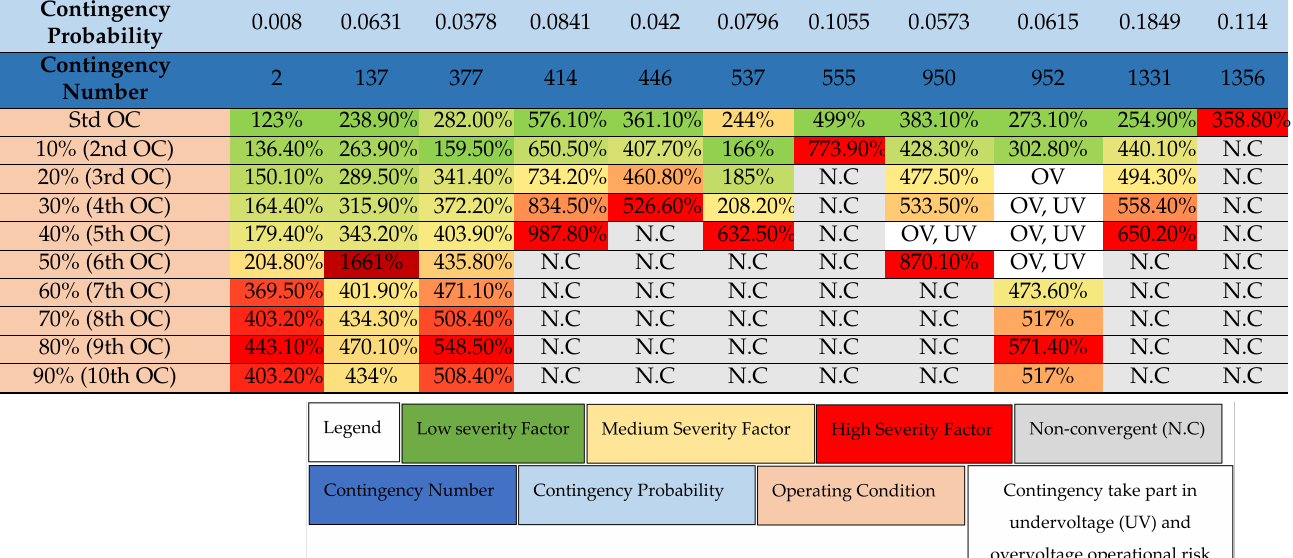
Table 3. Extreme loading severity factor behavior under varying operating